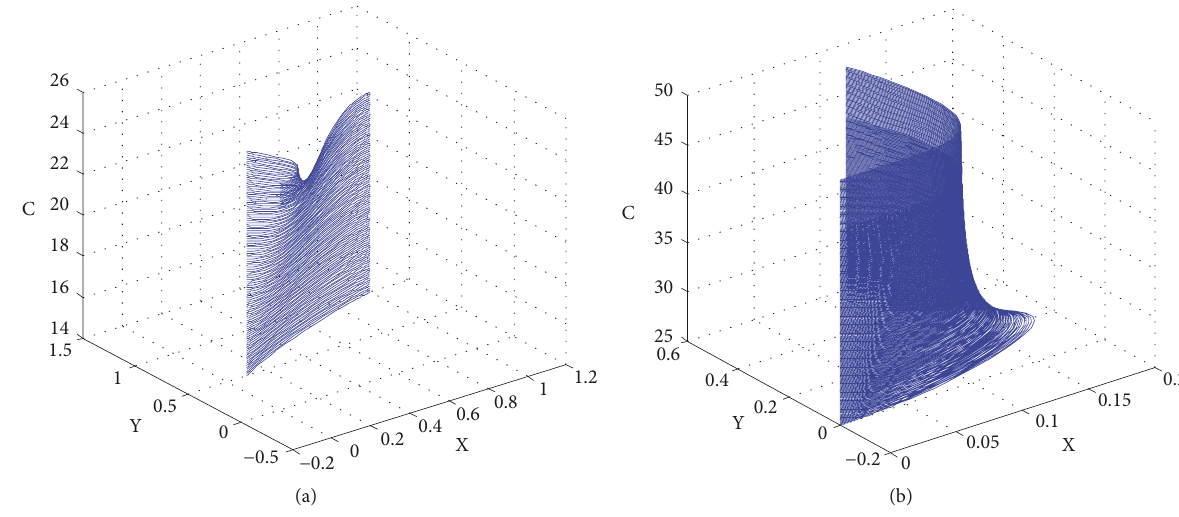
Figure 13: The simulation results with respect to the initial value of (0.1,0.5) and 𝐶 ∈ [14,50] in Scenario